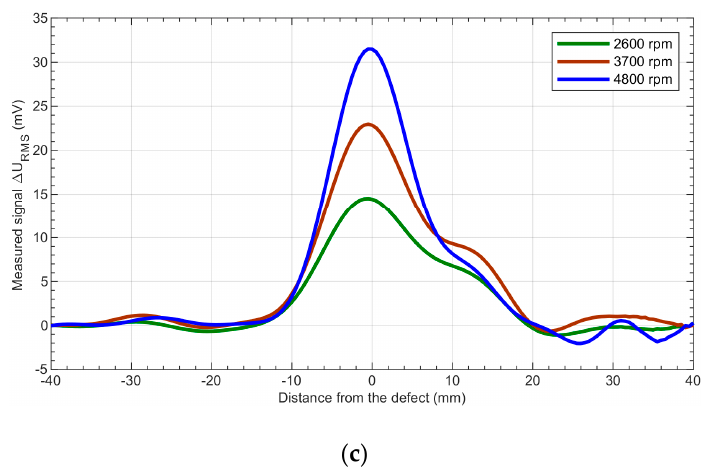
Figure 7. Results of the measurements executed for the aluminum samples with notches having depths of ( a ) 15 mm, ( b ) 6 mm, ( c ) 4 mm—comparison of the measured signals achieved at the different rotational speeds: 2600 rpm, 3700 rpm, and 4800 rpm.